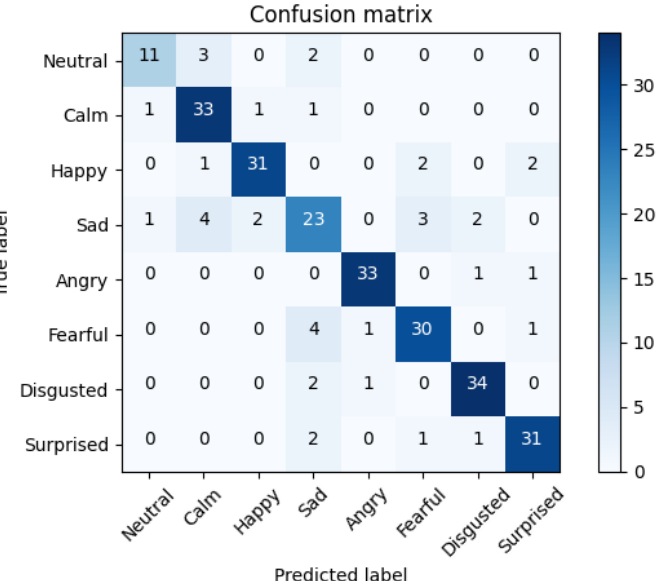
Figure 8. Average confusion matrix of the top late fusion strategy using a LinearSVC combining the top results of SER for the version without VAD and the FER for the version with VAD. Accuracy of 80.08%. See Table